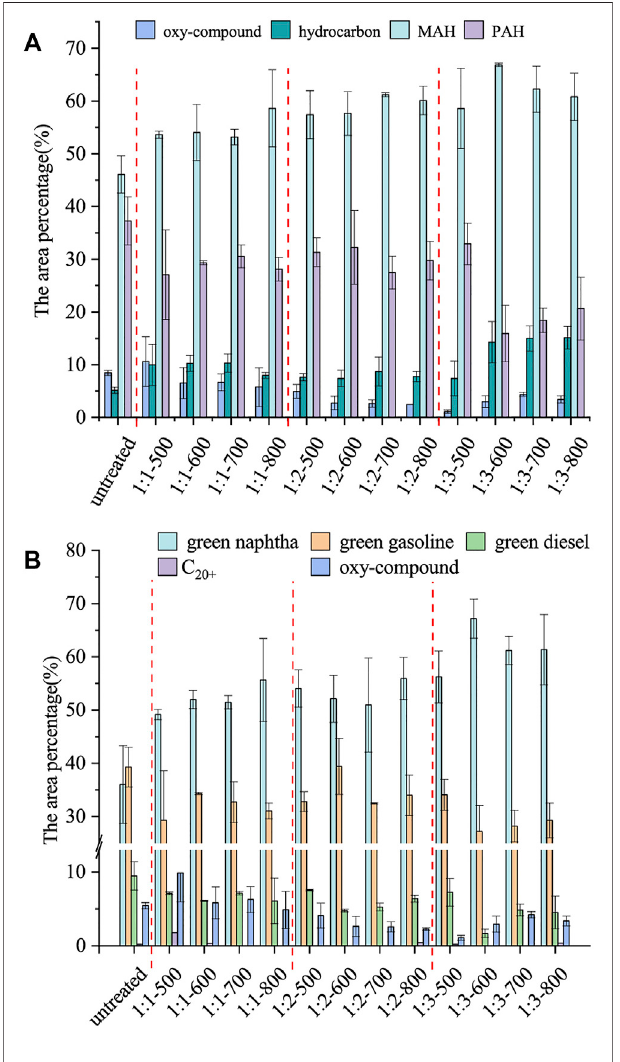
FIGURE4| DistributionofpyrolysisproductsofWVOatdifferentbiochar catalysts. (A) Area percentages of PAH, MAH, hydrocarbon (alkene and alkane),andoxy-compoundofbio-oil; (B) areapercentageofoxy-compound, C 20+ hydrocarbons, green diesel (C 13 – C 20 ), green gasoline (C 10 – C 12 ), and green naphtha (C 5 – C 9 ) in bio-oil.